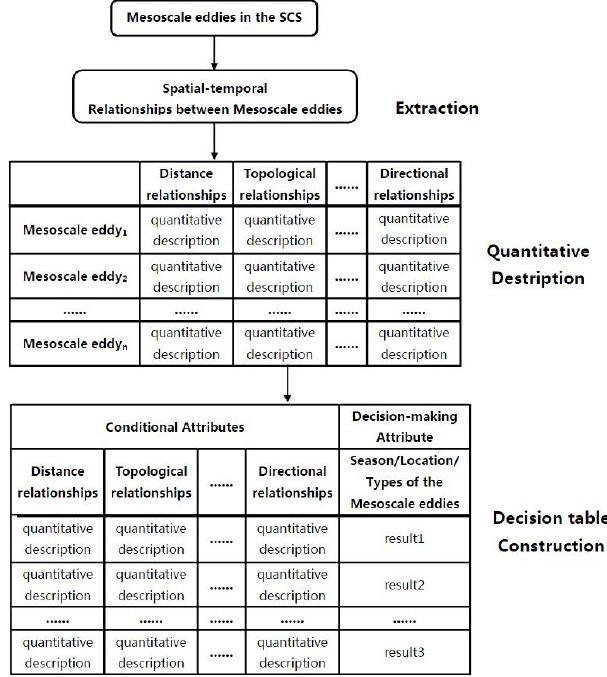
Fig. 3. Flowchart of major analysis steps based on the rough set